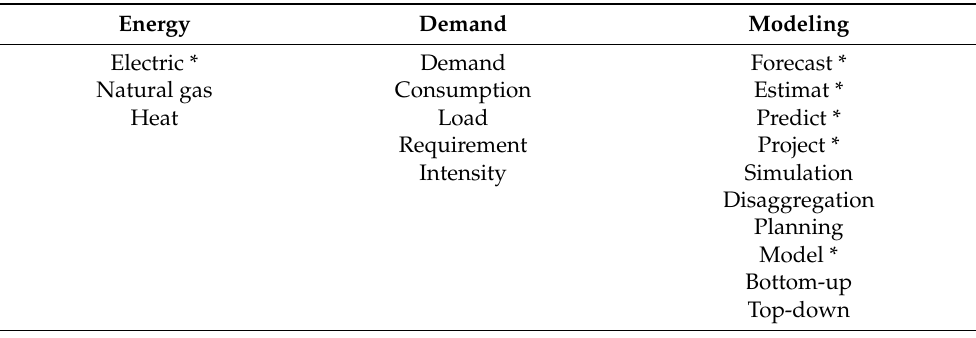
Excluded keywords: storage, carbon, emission, price, optimization, vehicle, climate Search string applied to the Web of Science Core Collection on 1 May 2021: (TI = ((electric* OR “natural gas” OR heat) AND (demand OR consumption OR load OR requirement OR intensity) AND (forecast* OR estimat* OR predict* OR project* OR simulation OR disaggregation OR planning OR model* OR “bottom-up” OR “top-down”)) NOT TS = (storage OR carbon OR emission OR price OR optimization OR vehicle OR climate)) Table A3. Articles sorted by energy carrier and sector. A compilation of the results of the analysis regarding energy carriers and sectors, which allows for direct tracing of the respective references.